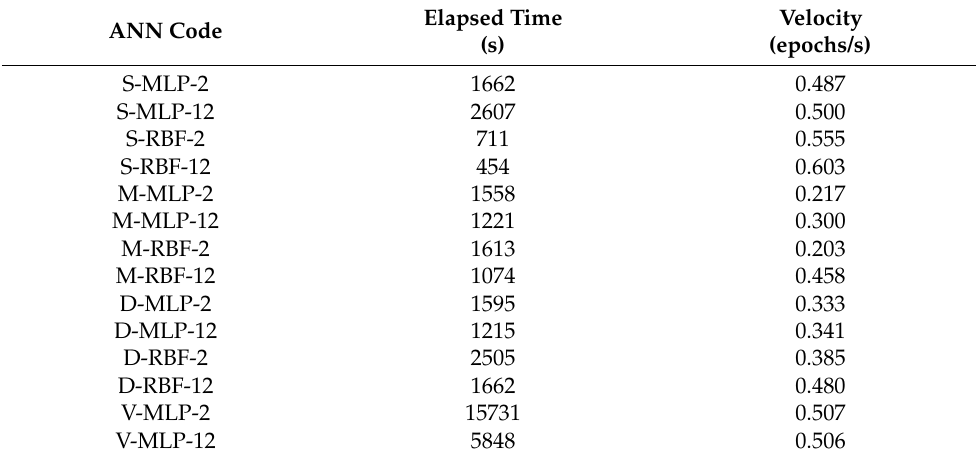
Table 10. Training time and velocity of all 16 neural networks tested with an i7 CPU with 32 GB of